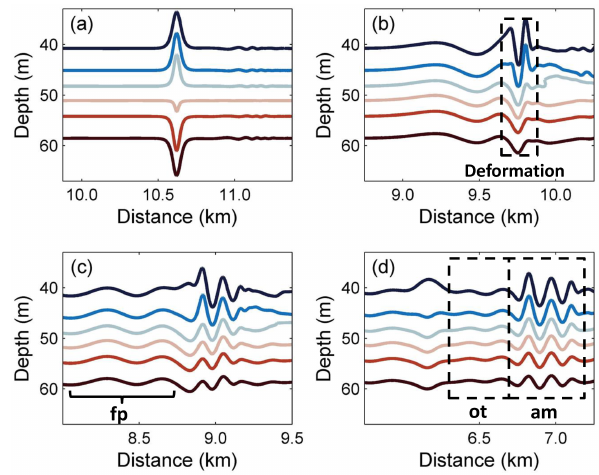
Figure 9. The evolution processes of the mode-2 ISW in case U5 for the different times (a) 0 T , (b) 10 T , (c) 20 T , and (d) 50 T , where “am”, “fp” and “ot” denote the amplitude-modulated wave packet, forward-propagating long wave and oscillating tail,